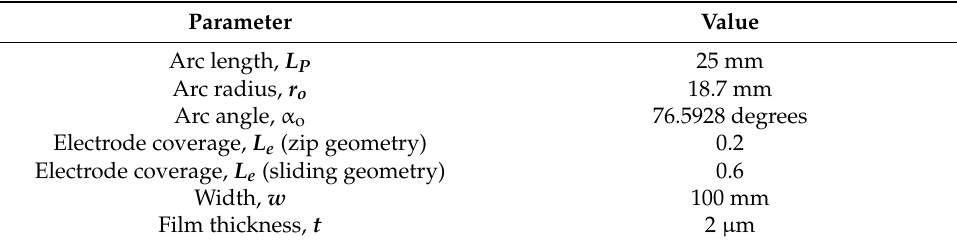
Figure 13. ( a ) A representation of the HASEL actuators arc segment radius (r o ), arc segment length (L p ), arc segment angle ( α o ), and the electrode coverage (L e ). ( b ) A representation of the HASEL actuators (cid:48) width (w) and arc segment length (L p ) [3]. Table 1. Geometric parameters.